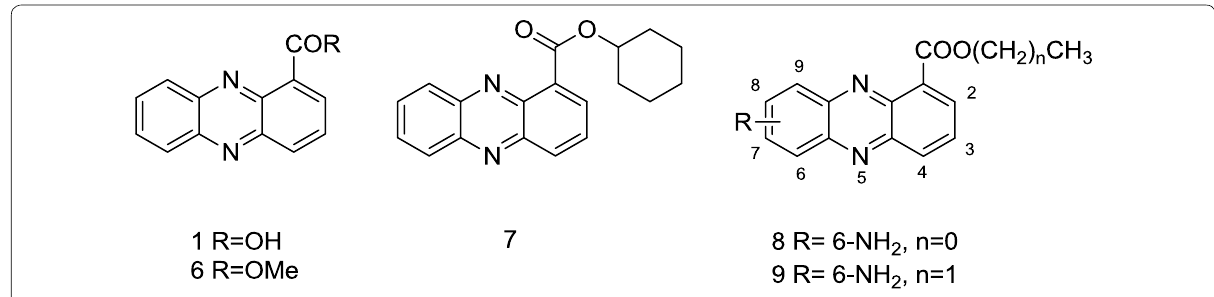
Fig. 1 The structures of PCA and its derivatives